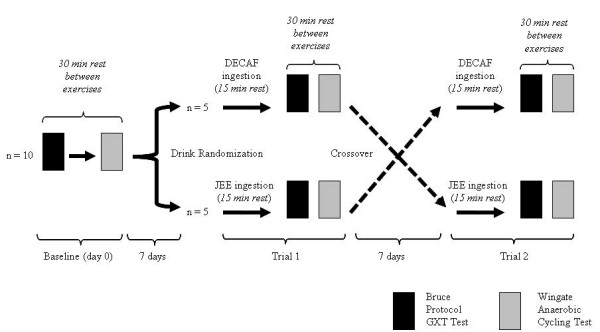
The crossover design employed during this study.